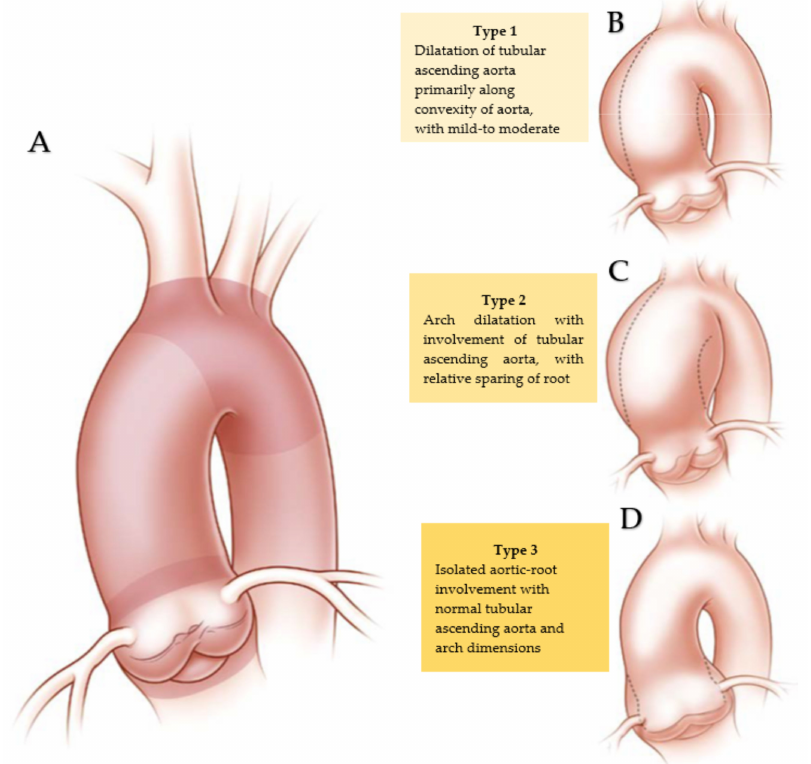
Figure 10. ( A – D ) . Depict patterns of bicuspid aortopathy revealing the biologic features of the aorta and the three types of bicuspid aortopathy. The three morphological types reported provide a substan- tial contribution to the best surgical procedure to be used for the treatment of the bicuspid aortopathy. Licenses Centre Cardiologique du Nord; order date 27 July 2022; order number 5357160571198; publication NEJM; title: Aortic Dilatation in Patients with Bicuspid Aortic